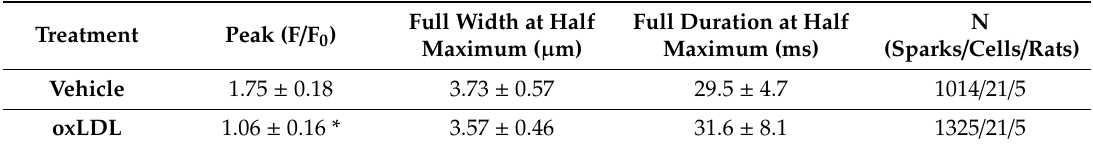
Table 3. Ca 2 + spark characteristics in cardiomyocytes acutely perfused with vehicle or 10 µ g / mL oxidized low-density